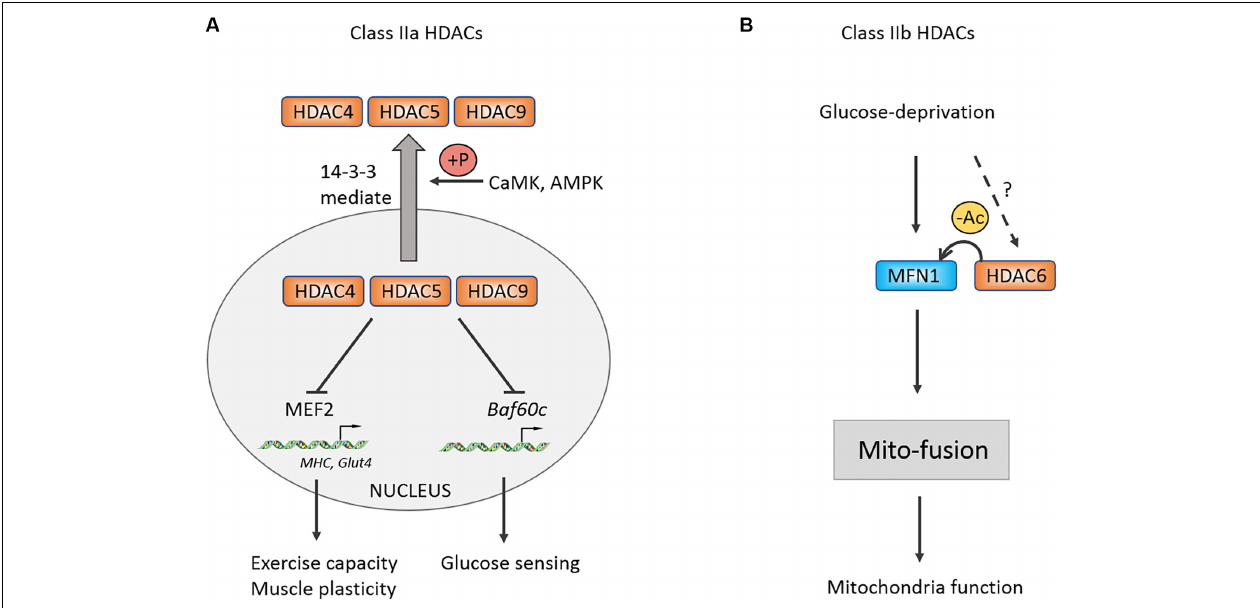
FIGURE 3 | Control of muscle exercise adaption and mitochondrial function by Class II HDACs. (A) Schematic of the Class IIa HDACs nucleoplasm shuttle. Under stress condition, CaMK and AMPK could be activated and phosphorylate Class IIa HDACs. Phosphorylated HDACs then bind with 14-3-3 and shuttle to cytoplasm, relieving inhibitory effects on MEF2 and Baf60c . (B) Class IIb HDAC6 can deacetylate MFN1 and facilitates its mito-fusion function. +P,